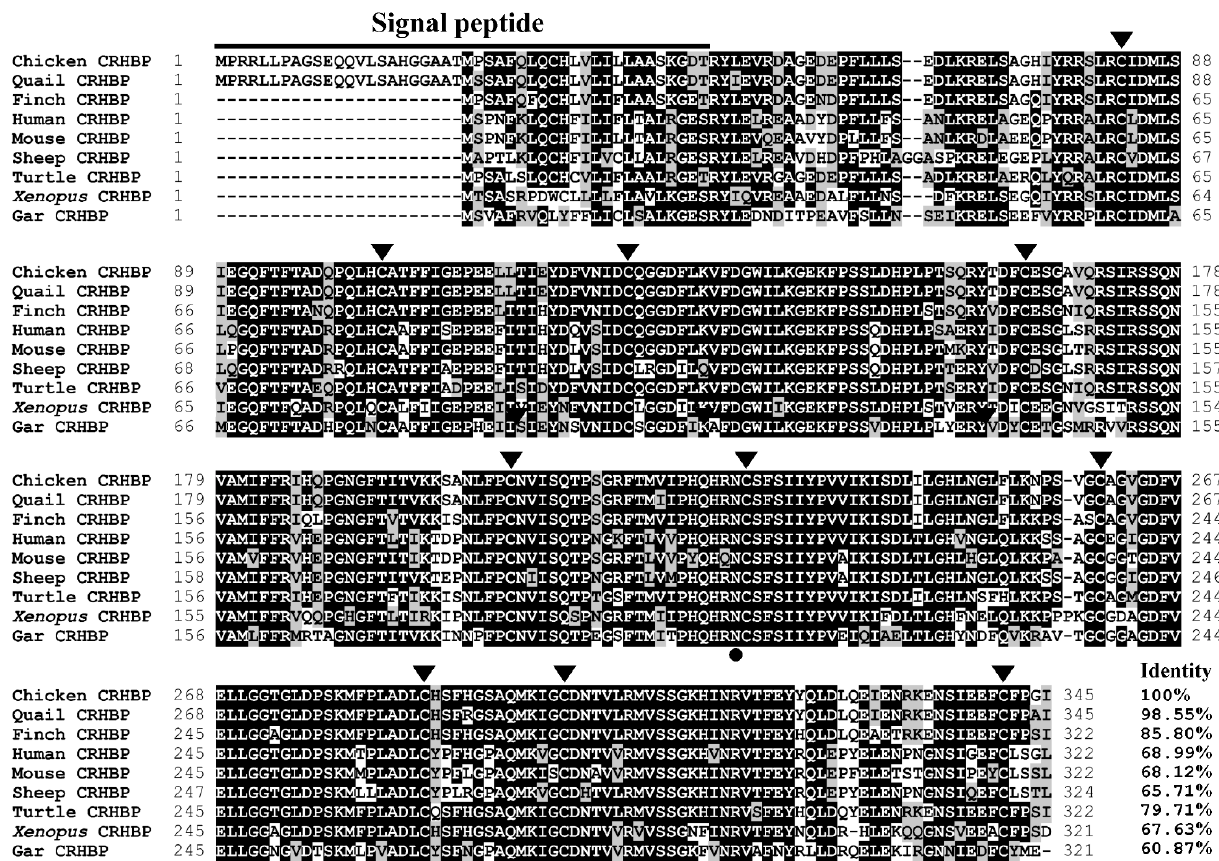
Figure 2. Amino acid sequence alignment of the chicken CRHBP precursor with that of Japanese quails (XP_015704133), zebra finches (XP_002190680), humans (NP_001873), mice (NP_940800), sheep (NP_001009339), Chinese soft-shelled turtles (XP_006119190), Xenopus tropicalis (XP_002940913) and spotted gars (XP_006626779). The horizontal line represents the signal peptides of the chicken CRHBP (46 amino acids). The ten conserved cysteine residues are marked with triangles. The location of N-linked glycosylation is marked with a circle. Identical amino acid residues are shown in black, whereas similar residues are labeled in gray. The identity of the CRHBP amino acid sequences between chickens and other vertebrate species was calculated and shown.